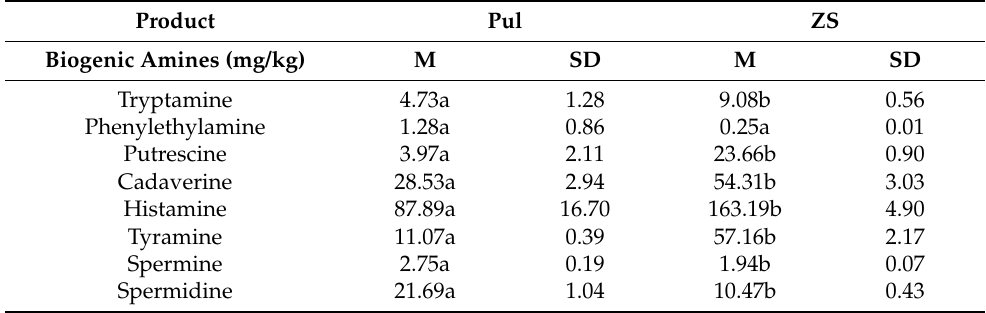
Table 3. One-factor analysis of the variance of the biogenic amine content of dry-cured ham. Product Pul ZS Biogenic Amines (mg/kg) M